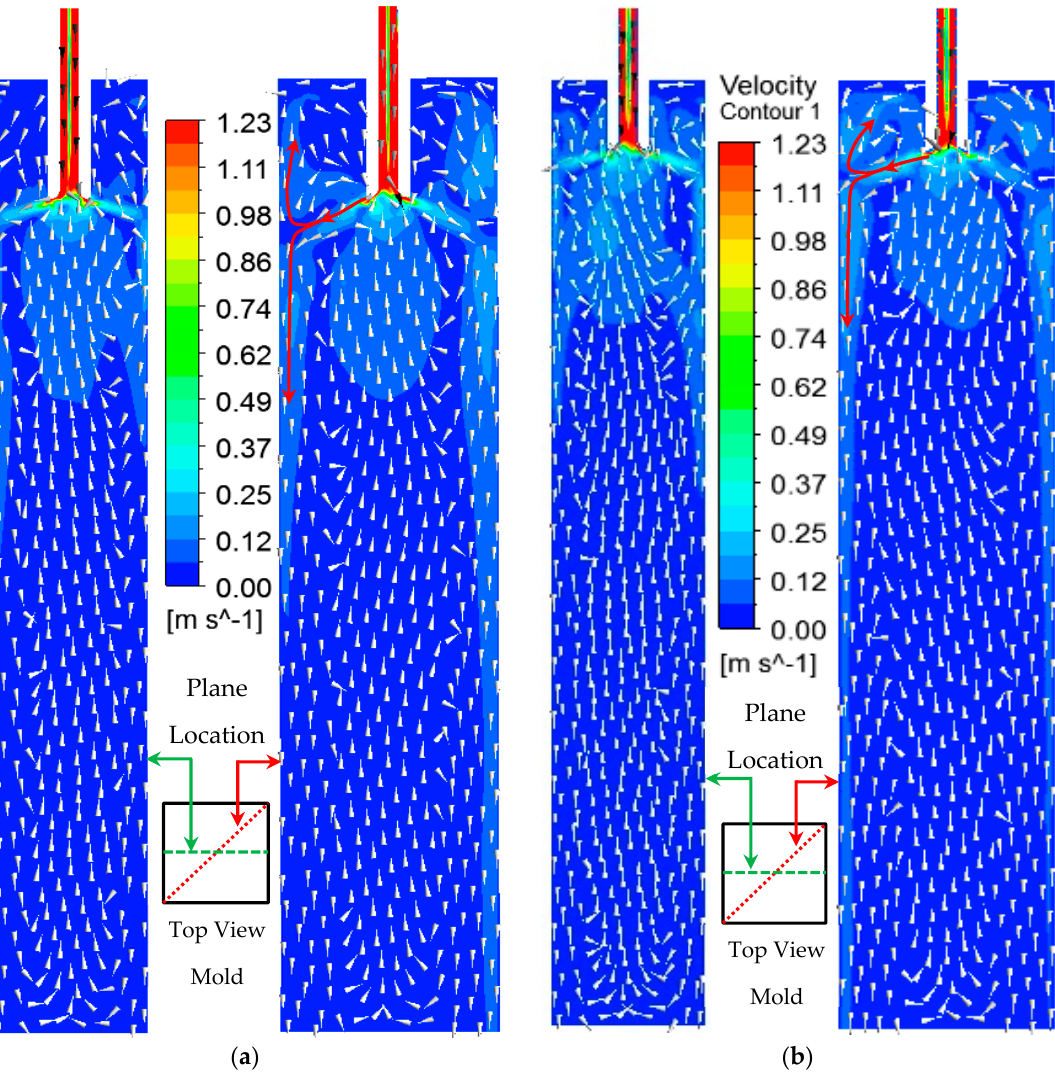
Figure 3. Steel flow velocity in the vertical middle plane of the mold, ( a ) SEN immersion depth of 0.25 m and ( b ) SEN immersion depth of 0.15 m [26]. (Arrows are the steel flow directions).